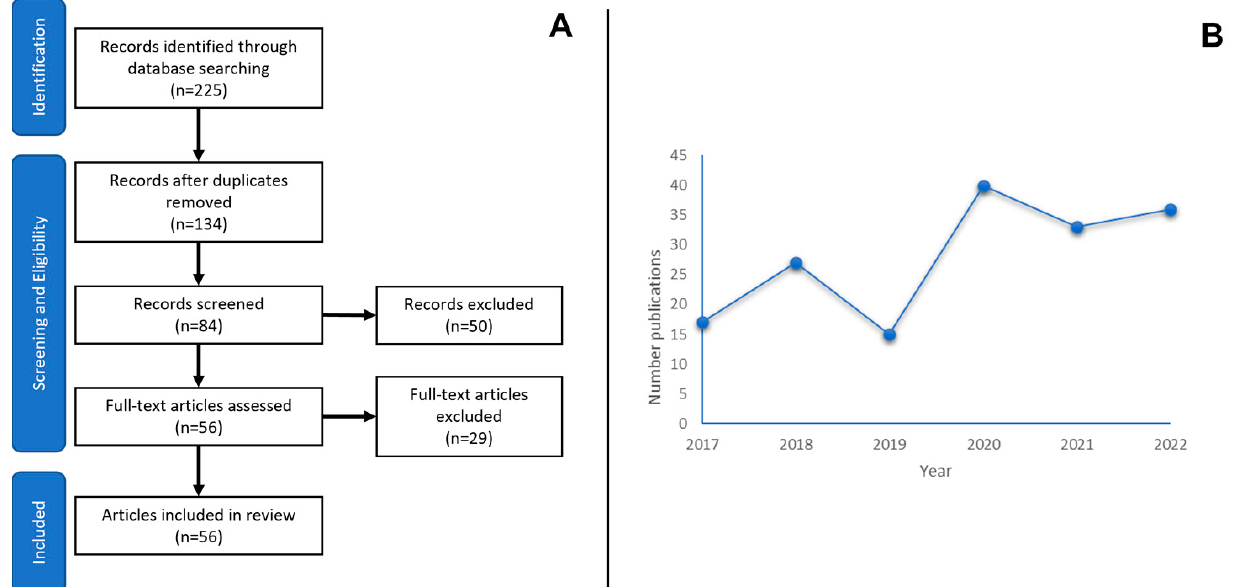
Figure 3. ( A ) PRISMA flow diagram (adapted from Page et al. [20]). ( B ) Evolution of s c i - e n t i f i c p u b l i c a t i o n s in the last five years on the topics of “water” and “wastewater” on CE in the LAR.